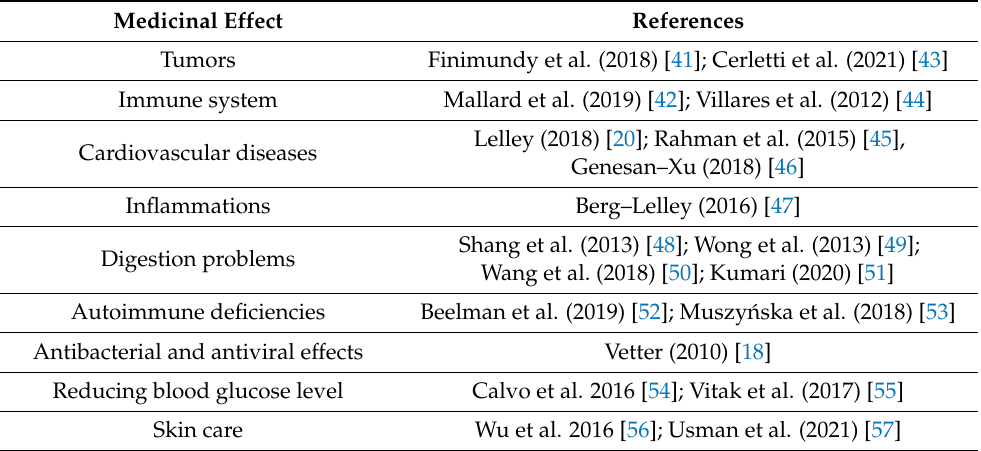
Table 1. The significance of medicinal